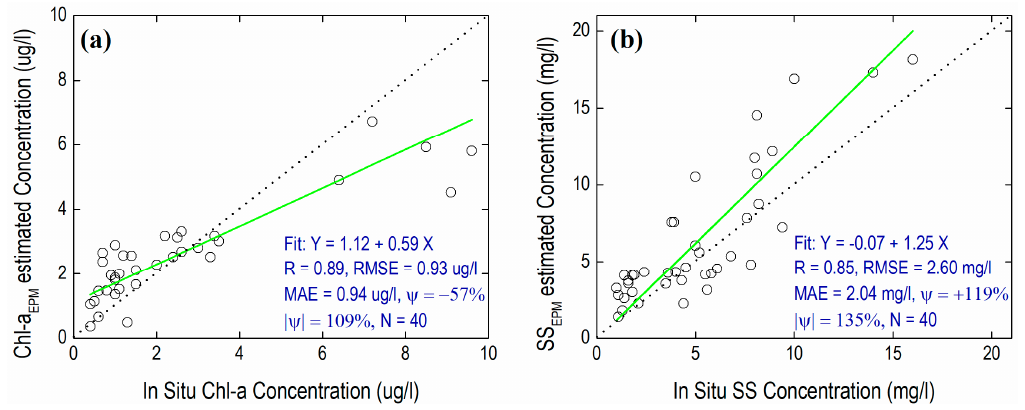
Figure 2. Validation results of regional empirical predictive models for ( a ) Chl-a and ( b ) SS concentrations.